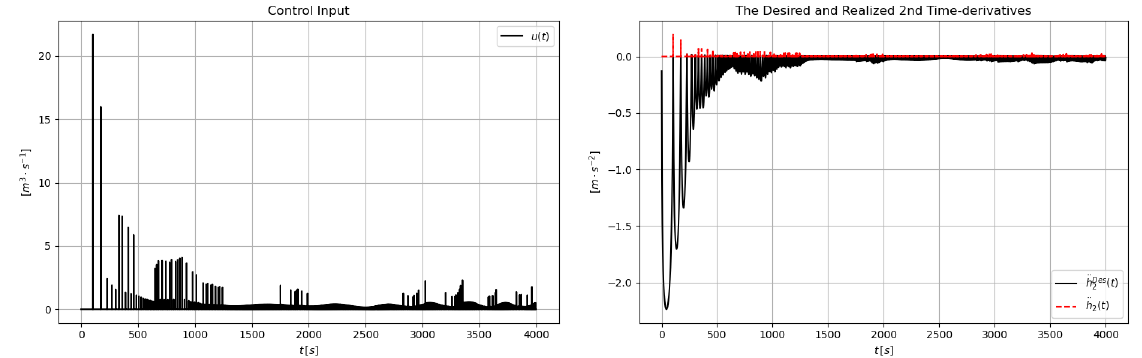
Figure 4. The adaptive control input and the second time-derivatives with their zoomed in excerpts for Λ max = 5.5 with